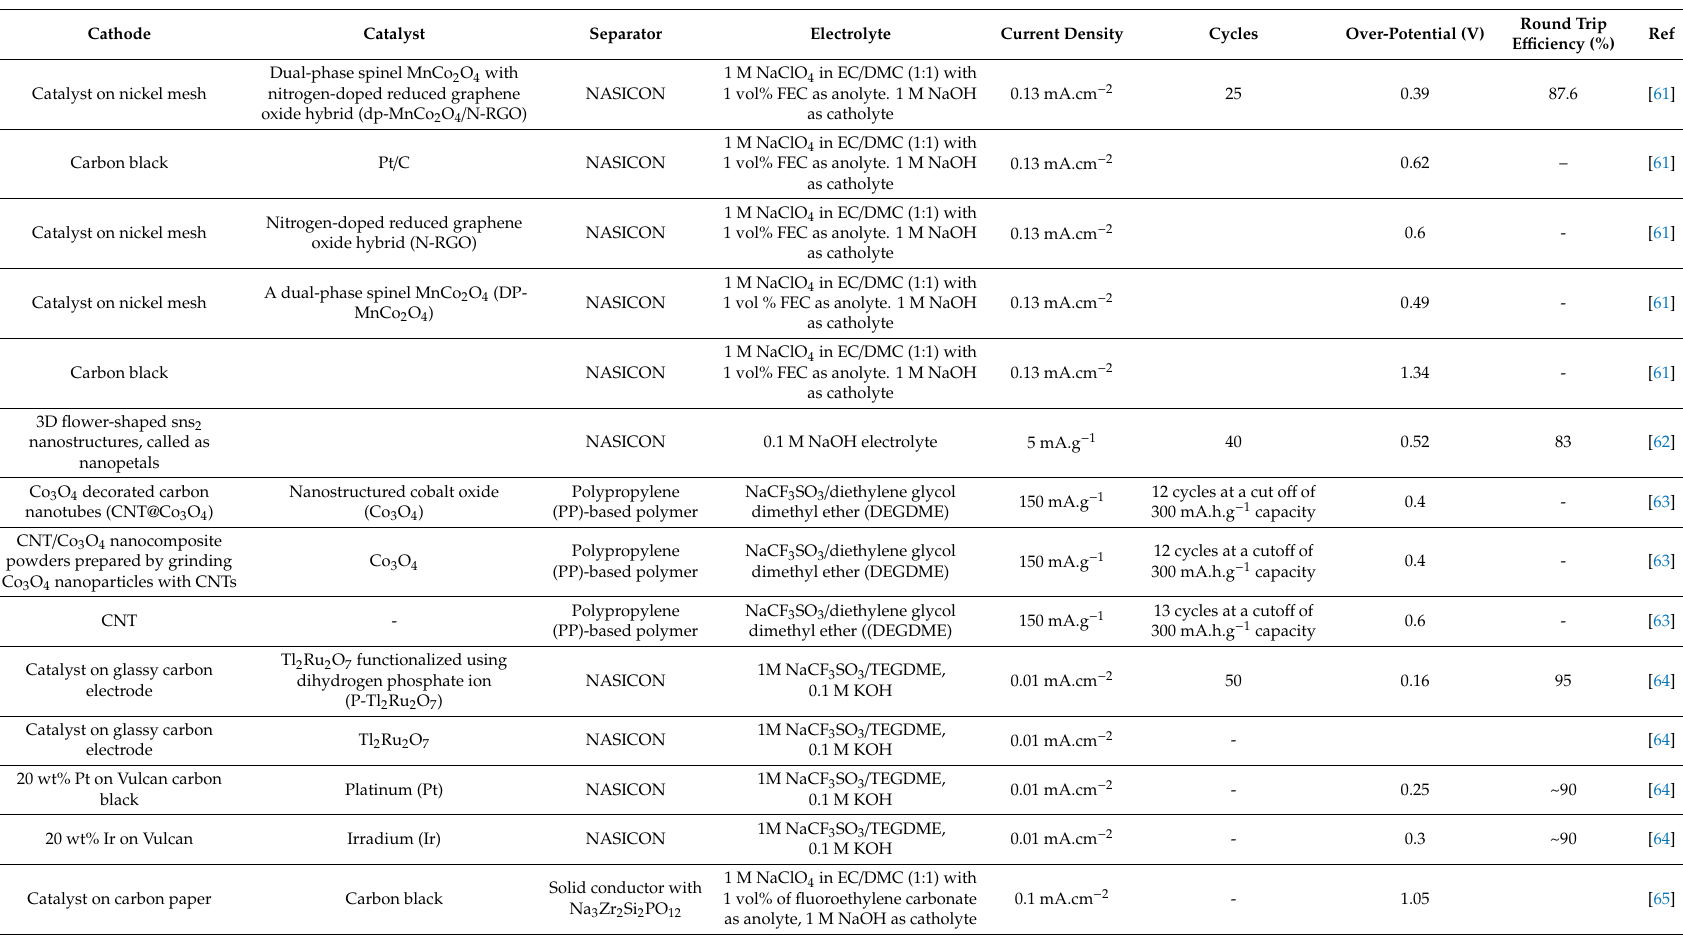
Table 2. Literature review of components and performance of various Na-air batteries. Lithium metal was the anode in all cases. Cathode Catalyst Separator Electrolyte